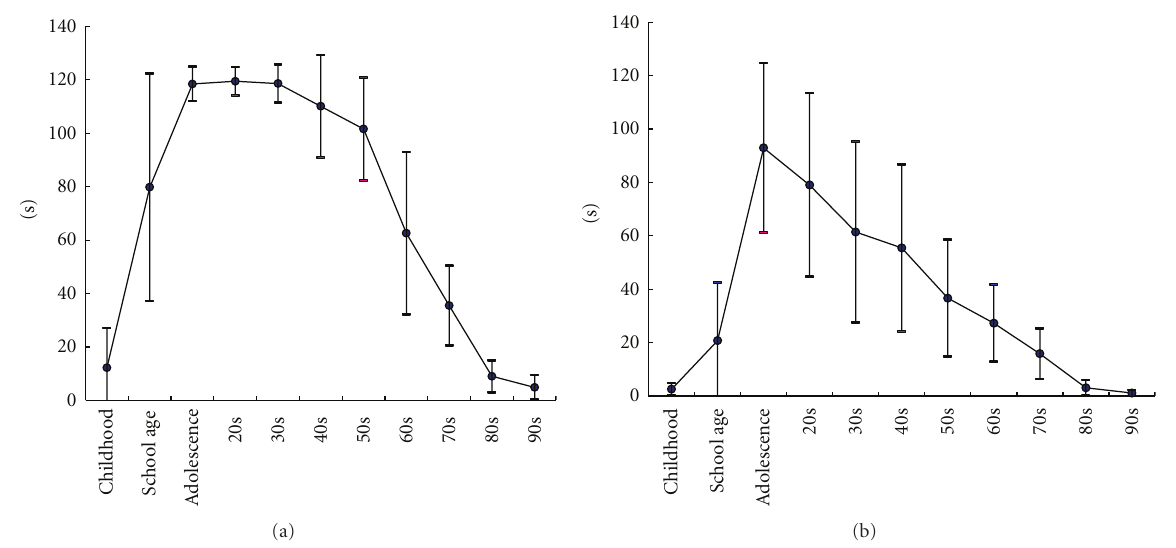
Figure 3: Changes to mean of the standing time on one leg time with the generations. It found the form was similar to trapezoid with its top from adolescence to 30s for open eyes (a). For closed eyes (b), the shape was similar to triangle with its top at adolescence.